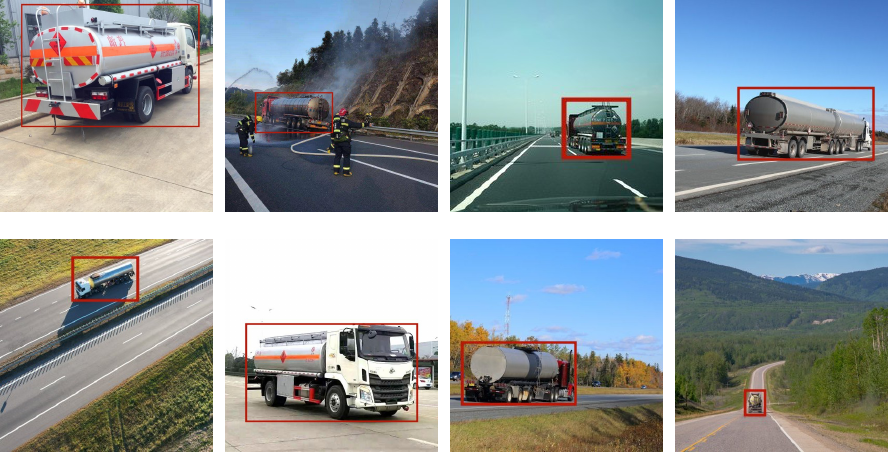
Figure 11. A subset of single hazardous material vehicle detection